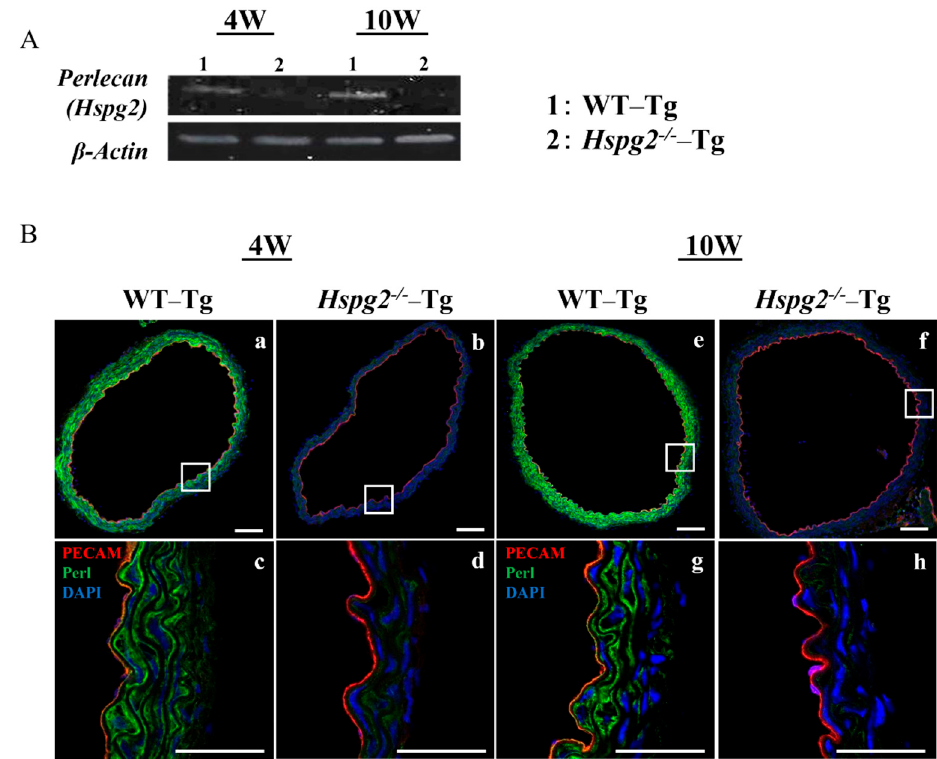
Figure 2. Expression of perlecan was low in Hspg2 − / − -Tg (without AD) aortic tissue. RNA and protein expression of perlecan in the aortic tissue of WT-Tg and Hspg2 − / − -Tg mice was confirmed by RT-PCR and immunofluorescence staining, respectively. ( A ) RT-PCR showed that perlecan mRNA expres- sion was absent in the aortic tissue of Hspg2 − / − -Tg mice. ( B ) Immunofluorescence staining showed that perlecan protein was expressed in the subendothelial basement membrane of WT-Tg ( a , c , e , g ) aortic tissue at 4 weeks and 10 weeks of age. We confirmed that perlecan protein expression was completely reduced in Hspg2 − / − -Tg mice ( b , d , f , h ). (Scale bar = 100 µm ( a , b , e , f ), 50 µm( c , d , g , h )).